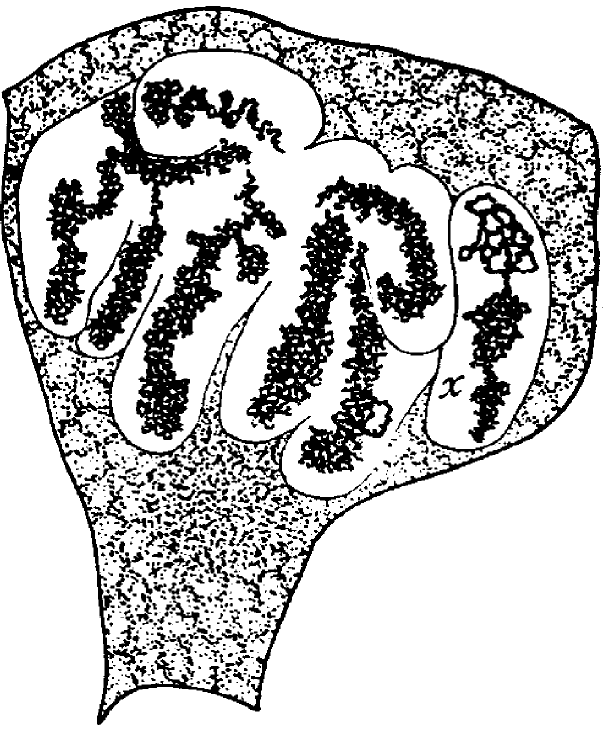
Figure 4 - Sutton’s drawing of Brachystola magna chromosomes during interphase, showing their separate